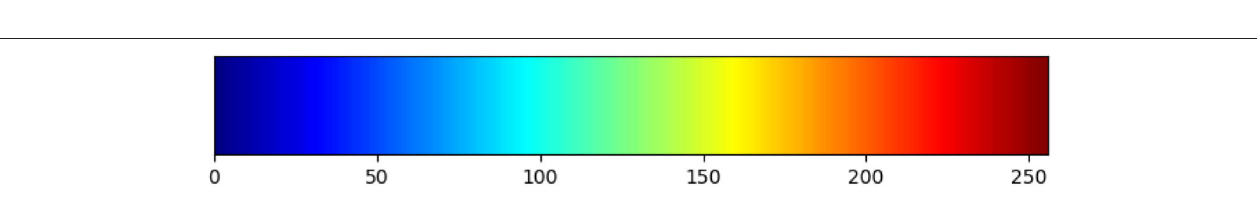
FIGURE 2 | Color scale of the thermal image. The temperature of an object was displayed with the corresponding color in the thermal